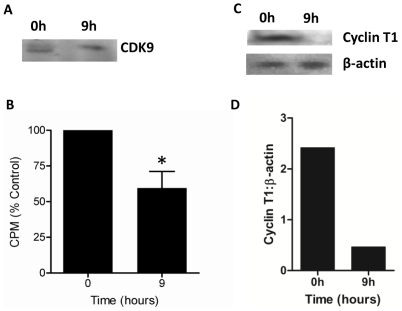
CDK9 activity and cyclin T1 expression decrease as neutrophils age in culture.Isolated human neutrophils were cultured for 9h and (a) CDK9 protein expression and (b) enzymatic activity were determined and compared with freshly isolated cells (0h). For CDK9 activity protein was immunoprecipitated from neutrophils with a monoclonal anti-CDK9 antibody and activity determined by incorporation of [γ 32P]-ATP into the CTD of RNA polymerase II. The phosphorylated peptide was isolated on an SDS-PAGE gel and excised for scintillation counting. Data are expressed as % of the value for control freshly isolated cells and are mean ± s.d. for three separate experiments. * indicates p<0.05. (c). Isolated neutrophils were cultured for 0 h or 9 h and expression of cyclin T1 determined by western blotting. Blots were probed with an antibody to β-actin to confirm equal protein loading. The blot shown is representative of 4 separate experiments performed. (d) Western blots of CDK9 expression relative to β-actin were quantitated using densitometry.